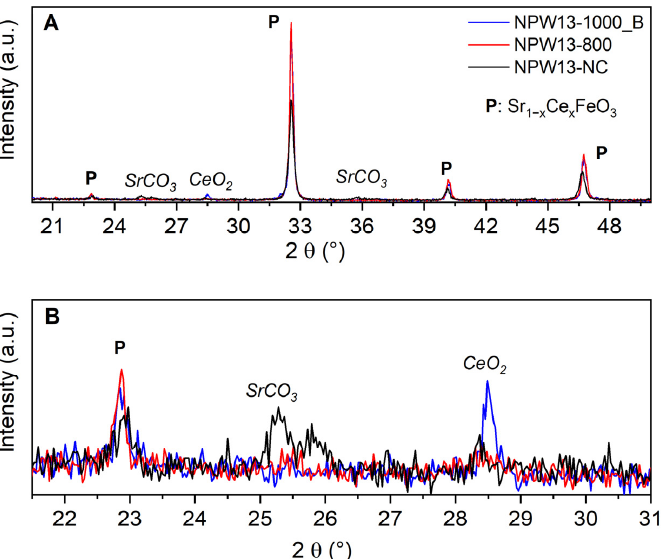
Figure 6. ( A ) XRD patterns of NPW13-NC, NPW13-800, and NPW13-1000_B; ( B ) an inset of the 21.5–31° 2 θ region showing the secondary phases.